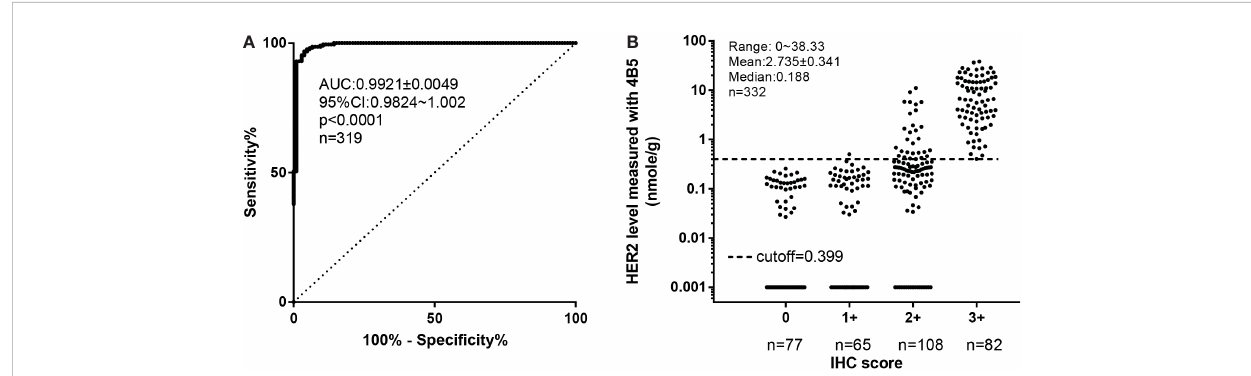
FIGURE 1 De fi ning the optimized cutoff for 4B5 using receiver operating characteristic (ROC) analysis based on the standard protocol of FISH/IHC analyses. (A) ROC analysis of QDB results. (B) The distribution of HER2 levels within each IHC category. All the FFPE specimens in cohort 1 were categorized as Her2+ and Her2 − based on combined IHC and FISH analyses. FISH results superseded the IHC results whenever a con fl ict occurred. Her2 levels measured by the QDB method using the 4B5 antibody were plotted against categorized Her2 results for ROC analysis ( n = 319) in (A) . In (B) , Her2 levels measured with QDB were plotted against each IHC categorized scores. Log scale was used to illustrate the performance of the proposed cutoff at 0.399 nmol/g. For specimens with undetectable Her2 levels, a value at 0.001 nmol/g was arbitrarily entered to avoid missing any specimen in the